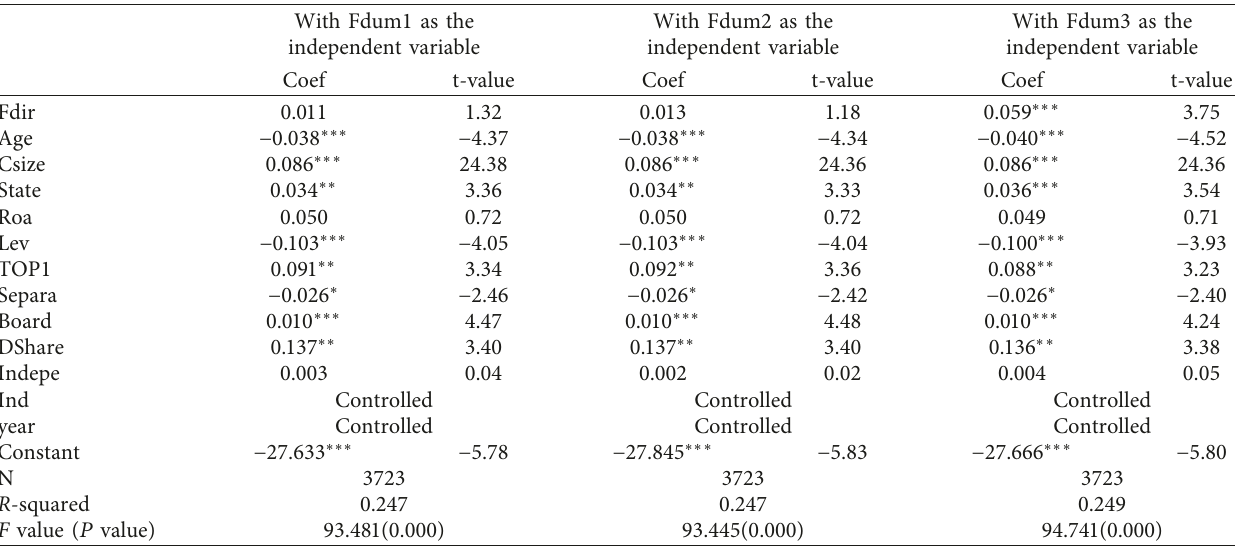
Table 10: Regression results of FDs’ influence on